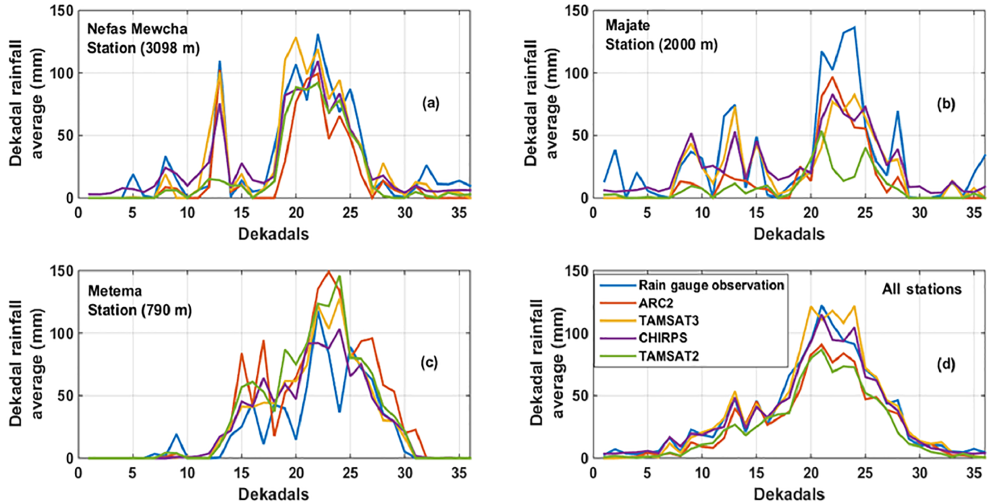
Figure 7. Comparison of the satellite products at gauge stations with wider difference in elevation values (e.g., >2000m), based on dekadal average over the Upper Blue Nile basin for the period of 2000–2015: (a) at “Nefas Mewucha” station with an elevation of 3098ma.s.l., (b) at “Majate” stations with an elevations of 2000ma.s.l., (c) at “Metema” stations with an elevation of 790ma.s.l., and (d) on dekadal rainfall average from all rain gauge stations. The x axis represents the 36 dekadals of a